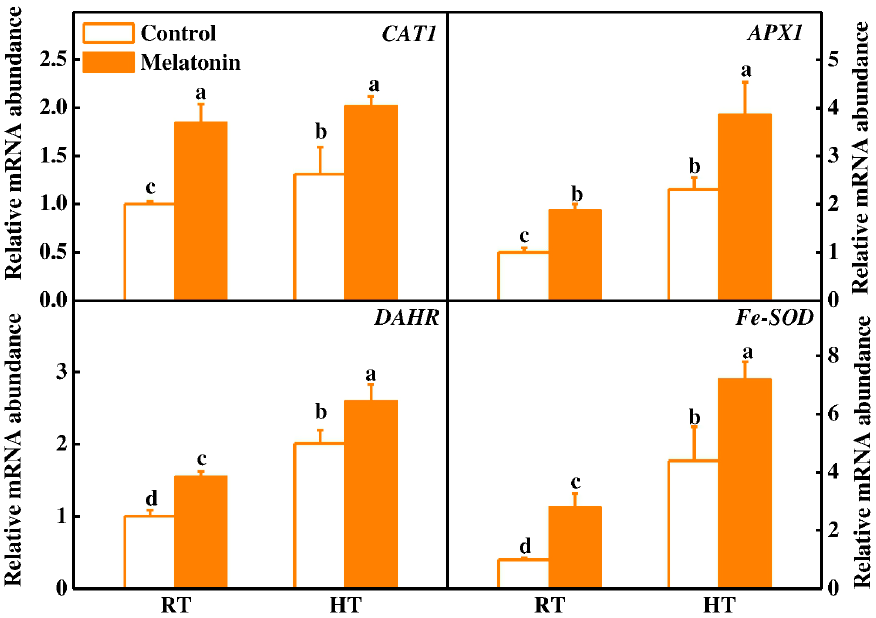
Figure 2. Melatonin enhances the ability of scavenging reactive oxygen species (ROS) in tomato anthers under high temperature stress. ( A ) Detection of superoxide anion (O 2 • − ) by nitro blue tetrazolium (NBT) staining and assay of hydrogen peroxide (H 2 O 2 ) by 2,7-dichlorofluorescein diacetate (DCF) staining. Bars = 1.5 mm (upper panel) and bars = 60 µm (lower panel). In the upper panel, the red arrow indicates the darker of the anther color, and the deeper of the tissue slice fluorescence, the more ROS has accumulated, which means that melatonin efficiently removed the ROS and alleviated ROS production in anthers under high temperature; ( B ) Relative fluorescence intensity is based on the DCF staining. The data shown are the average of four replicates, with the standard errors shown by vertical bars. Means denoted by the same letter did not significantly differ at p < 0.05, according to Tukey’s test.